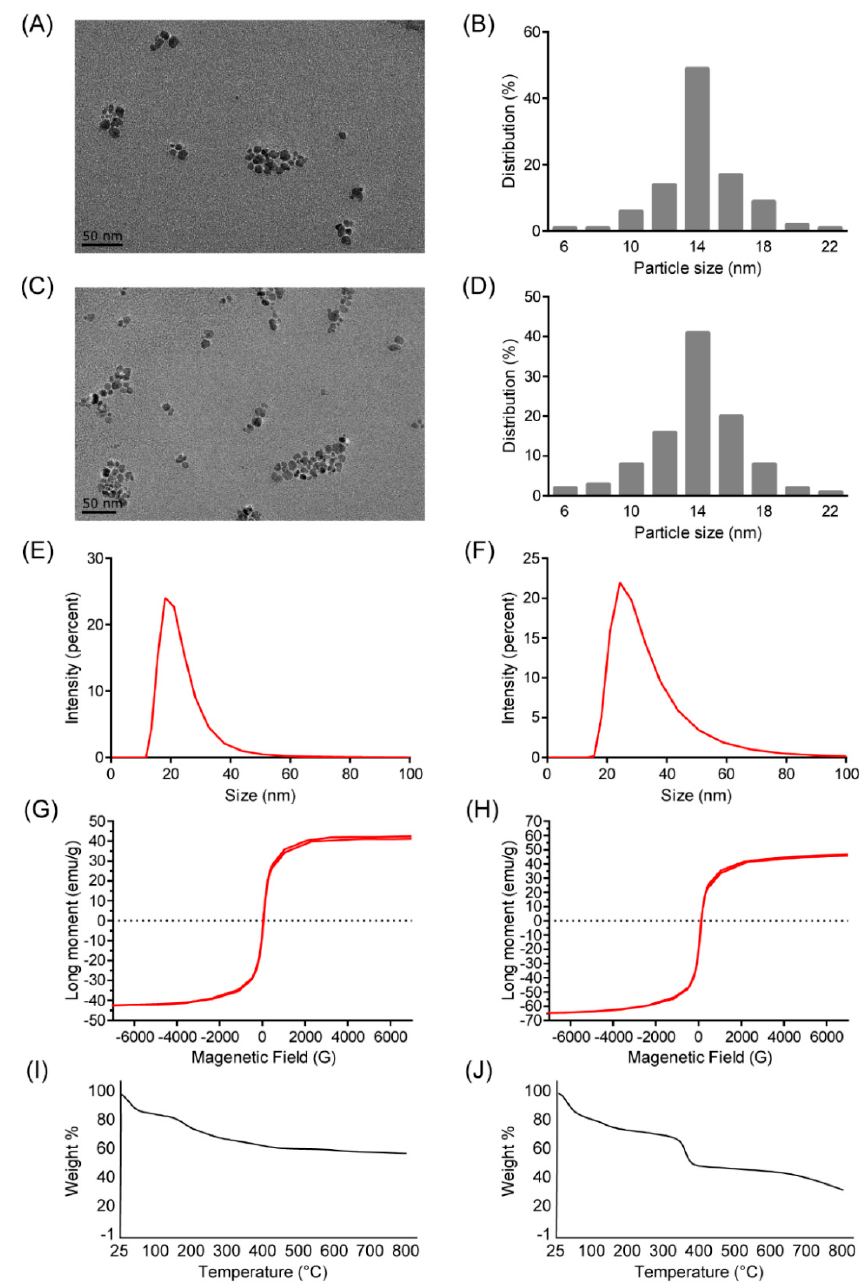
Figure 1. Characterization of the polyethyleneimine (PEI)-coated Fe 3 O 4 NPs. ( A ) The transmission electron microscope (TEM) image of the Fe 3 O 4 NPs without PEI. Scale bar indicates 50 nm; ( B ) the particle size distribution of the Fe 3 O 4 NPs without PEI, from the analysis of TEM images; ( C ) the TEM image of the PEI-coated Fe 3 O 4 NPs. Scale bar indicates 50 nm; ( D ) the particle size distribution of the PEI-coated Fe 3 O 4 NPs, from the analysis of TEM images; ( E ) the hydrodynamic size of the Fe 3 O 4 NPs without PEI, analyzed by dynamic light scattering (DLS). ( F ) the hydrodynamic size of the PEI-coated Fe 3 O 4 NPs, analyzed by DLS; ( G ) The magnetization curve of the Fe 3 O 4 NPs without PEI was analyzed by magnetization curve obtained by vibrating sample magnetometer (VSM) at room temperature; ( H ) The magnetization curve of the PEI-coated Fe 3 O 4 NPs was analyzed by magnetization curve obtained by vibrating sample magnetometer (VSM) at room temperature; ( I ) the thermogravimetric analysis curve of the Fe 3 O 4 NPs without PEI; ( J ) the thermogravimetric analysis curve of the PEI-coated Fe 3 O 4 NPs.